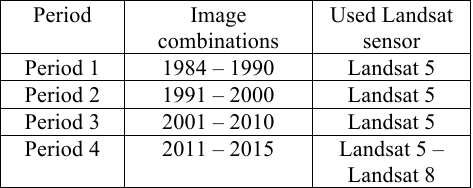
Table 1. The satellite sensor images used for change detection analysis and time periods